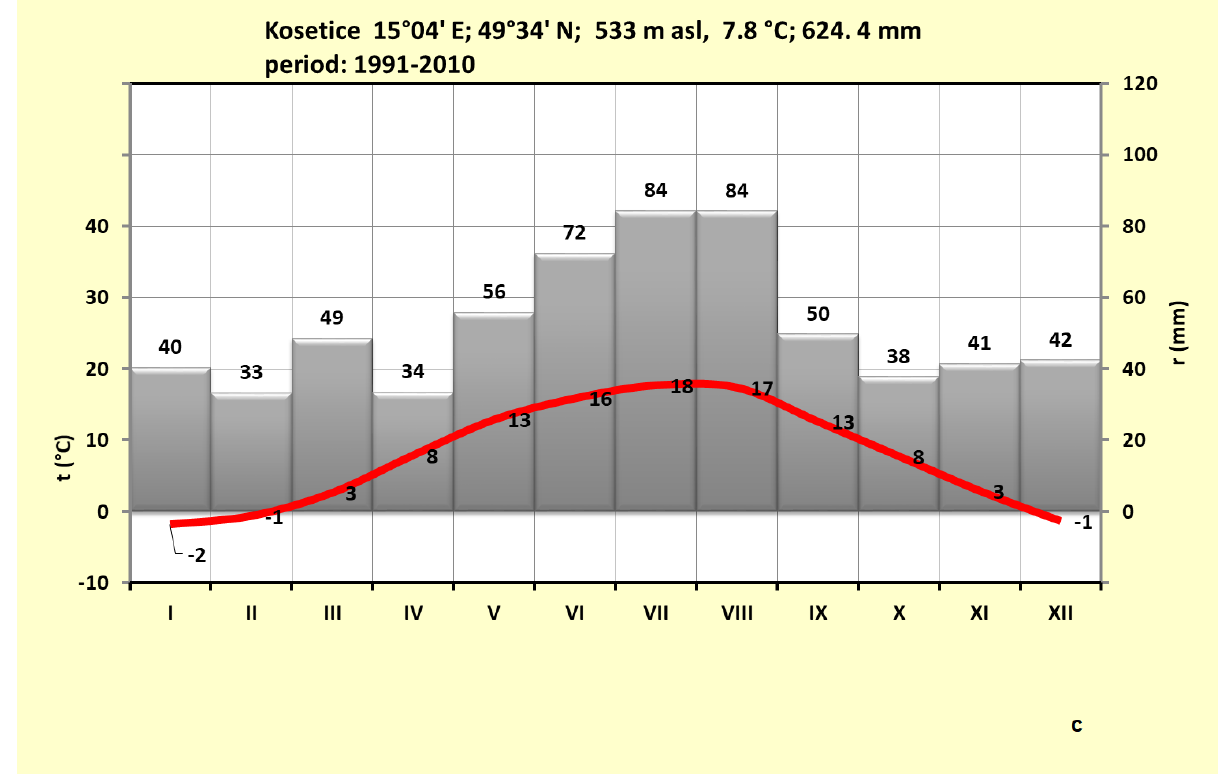
Figure 3. Climagrams of selected CHMI stations—Opava ( a ), Liberec ( b ) and Kosetice ( c ).